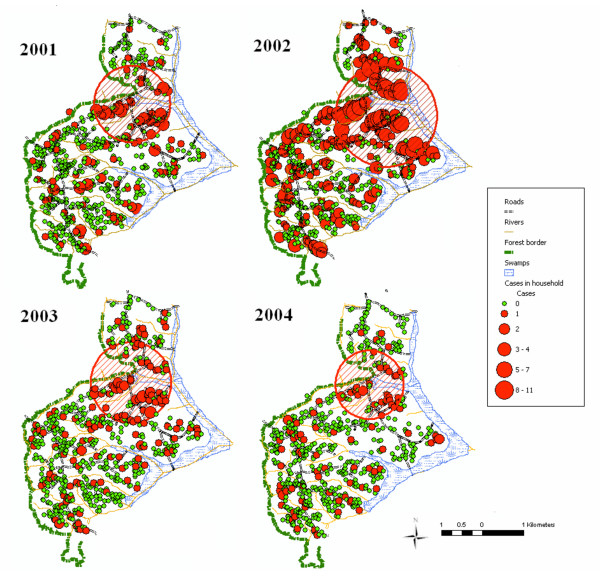
Malaria cases as detected by passive surveillance, 2001–2004. Red hatched area denotes significant clusters of disease as detected by Kuldorff scan.